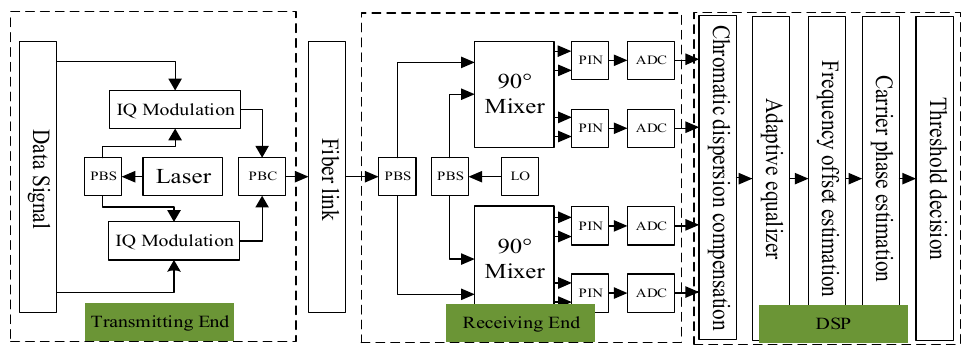
Figure 1. Coherent optical communication system structure diagram.